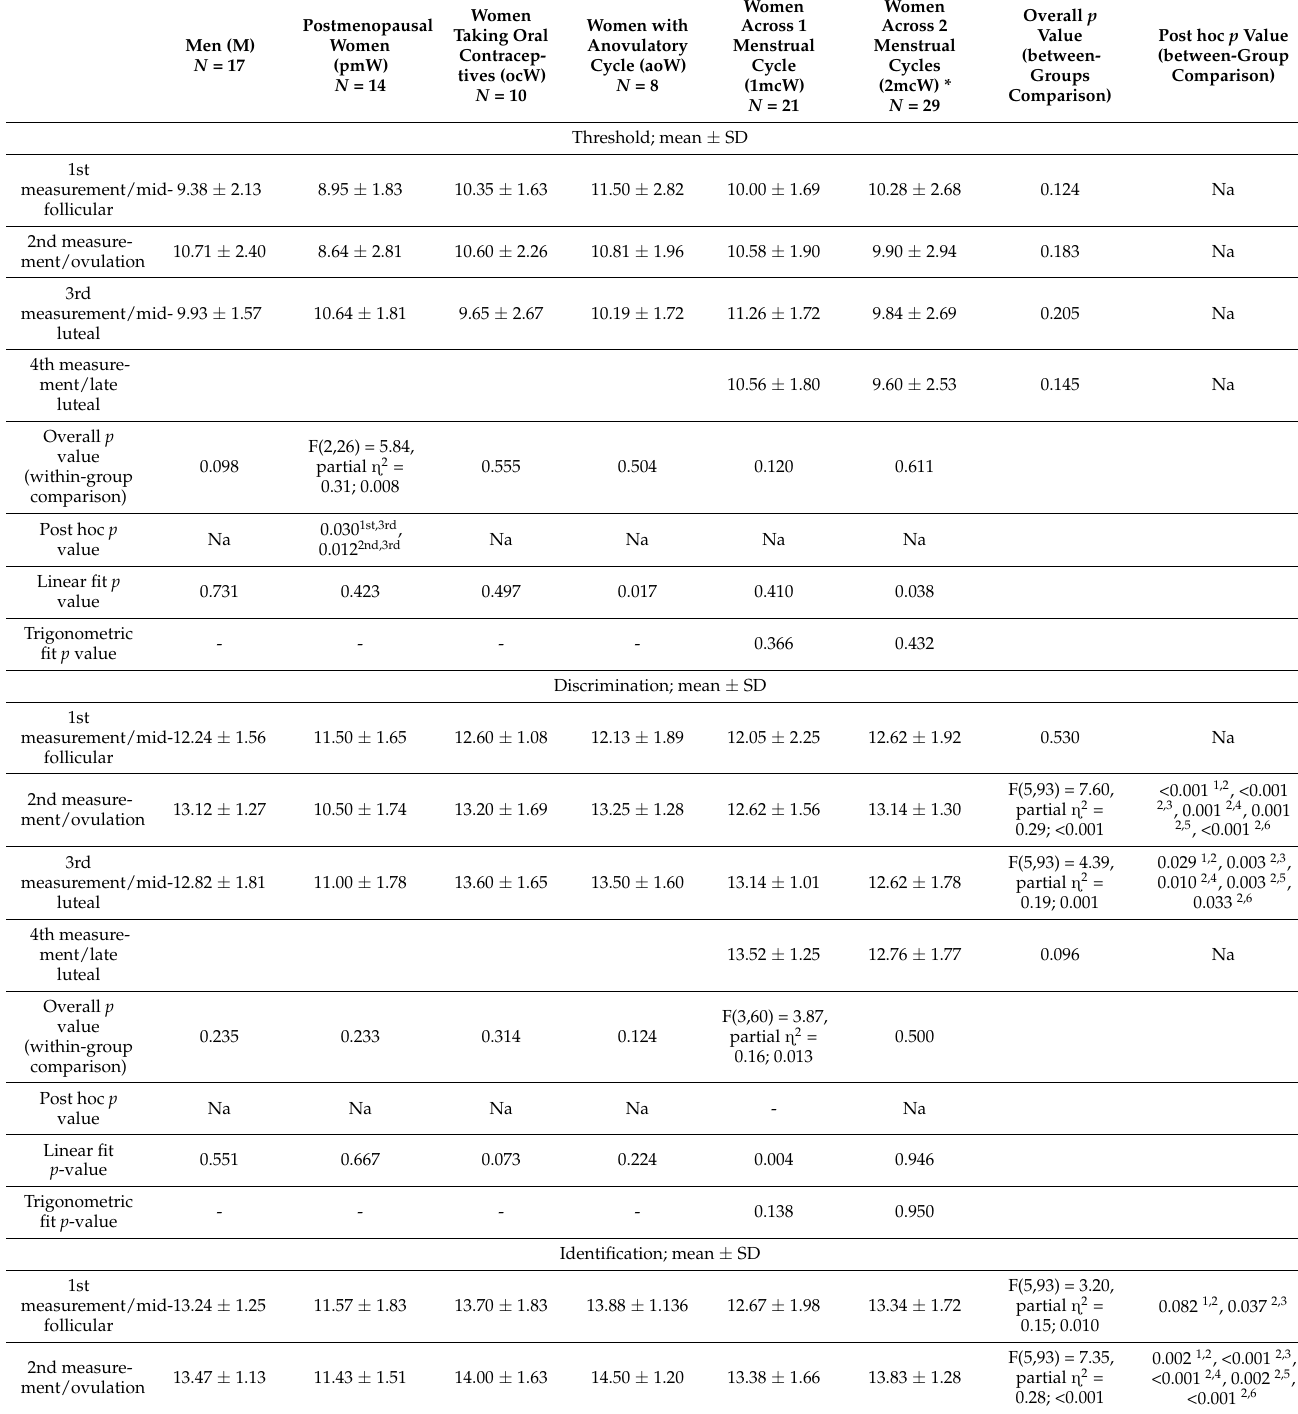
Table 2. Olfactory threshold, discrimination, identification test, and overall TDI scores (threshold, discrimination, and identification) for six groups of participants throughout measurement